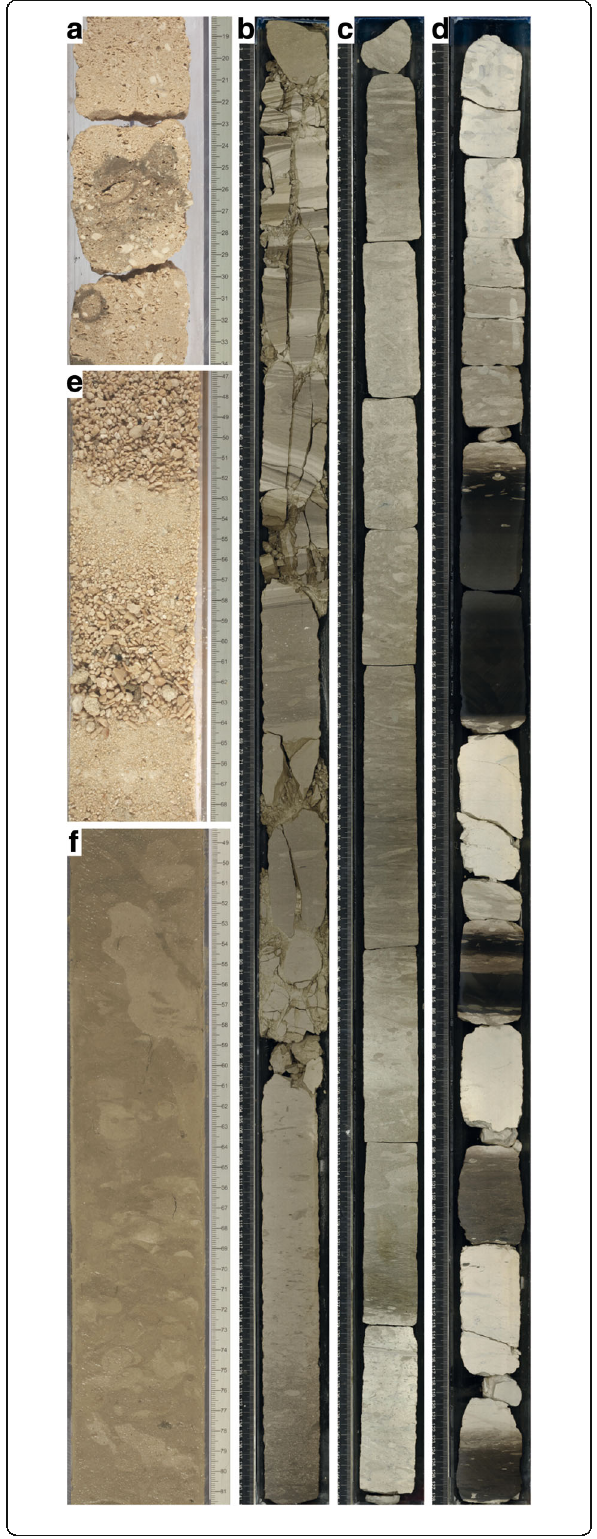
Fig. 6 Core photographs of the drift and carbonate platform facies discussed in the text. a Shallow water limestone with red algal debris and bioclasts (Core 359-U1465B-4R-1, 18 – 34 cm). b Slope deposits with slumped layers (Core 359-U1466B-52R-3, 0 – 150 cm). c Distal slope to basin deposits characterized by intervals with higher platform export (lighter color) and intervals with reduced platform export (darker color) (Core 359-U1471E-43R-1. 0 – 150 cm). d Pelagic chalks with dark TOC- rich intervals (Core U1466B-56R-1, 0 – 150 cm). e Drift fan deposits